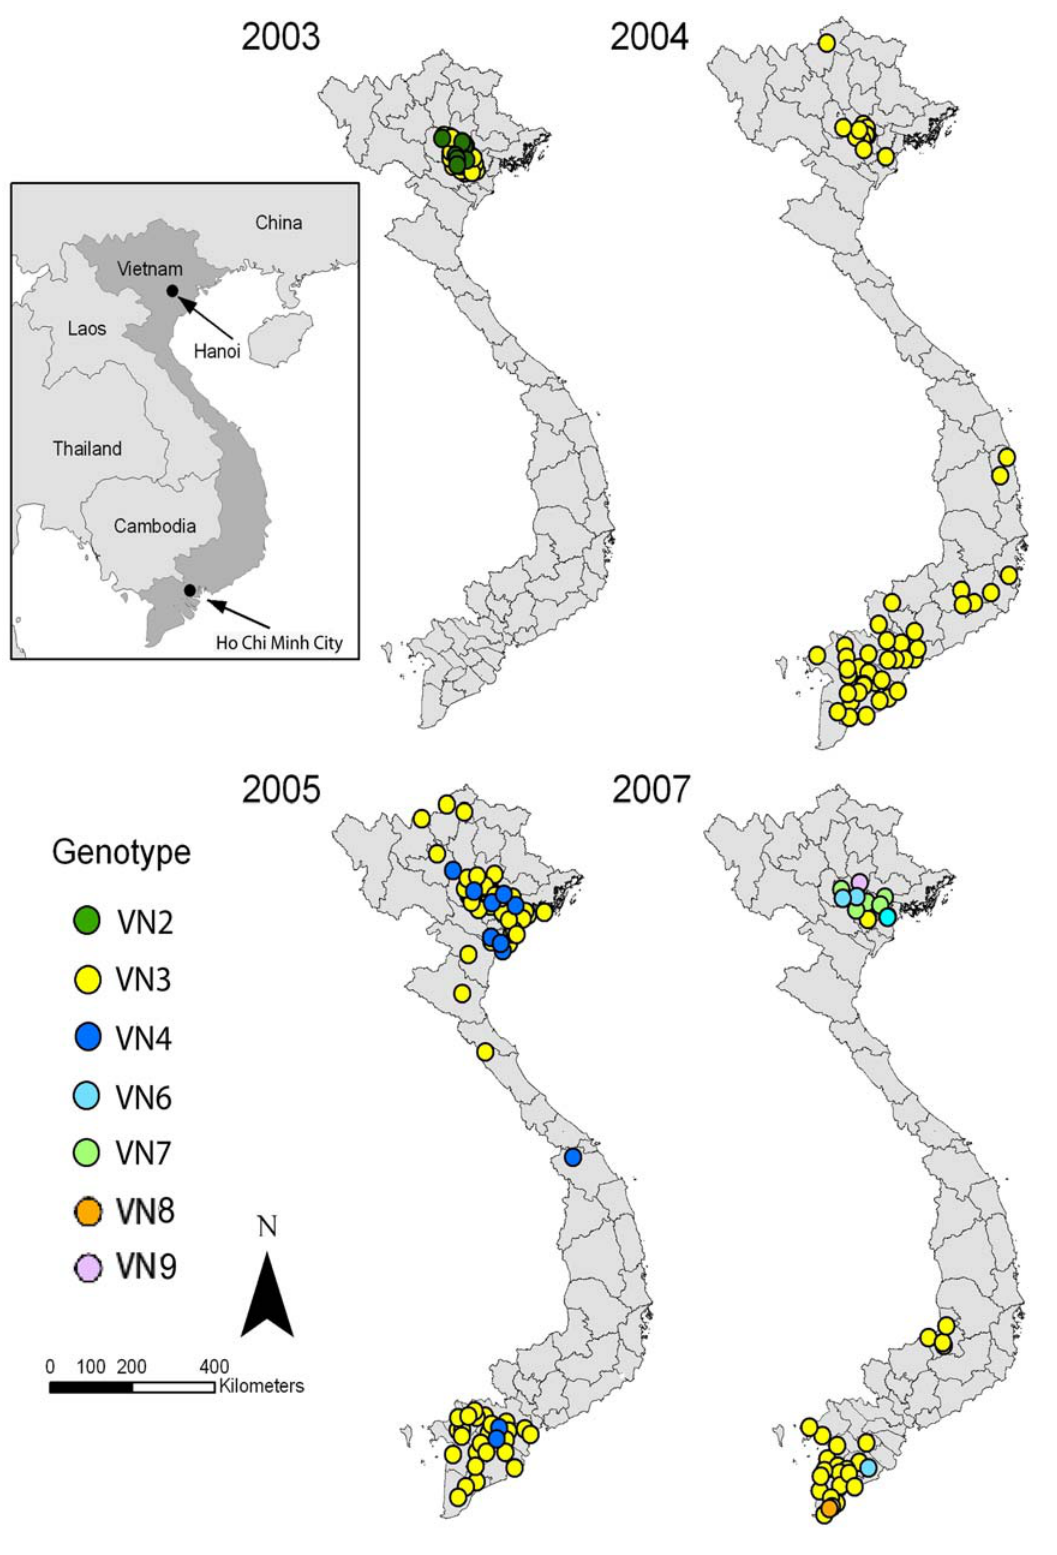
Figure 4. Geographic distribution of the genotypes identified for 142 H5N1 viruses isolated in Vietnam from 2003 to 2007. The viral genotype of each H5N1 isolate was mapped chronologically to show the time of genotype isolation in certain regions of Vietnam. VN5 was not shown in this figure since the geographic locations of these viruses were not known. The strain name, genotype, and collection location of each isolate are listed in Table S1.